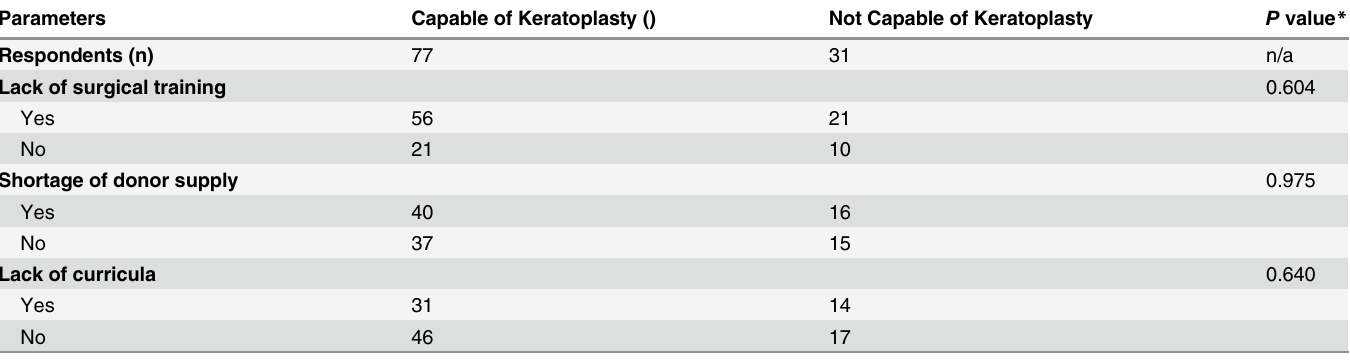
Table 5. Reasons for Low Keratoplasty Volumes in China.